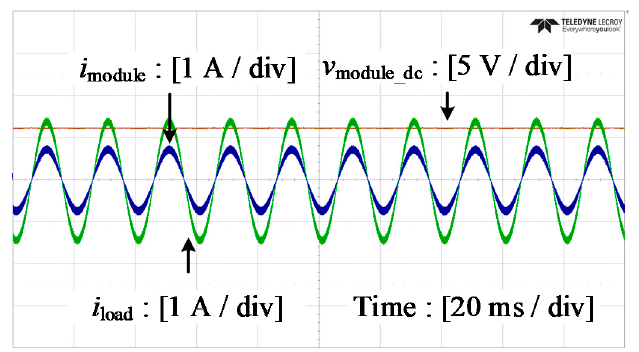
Figure 18. Experimental results of the lattice converter with pulse-width modulation.